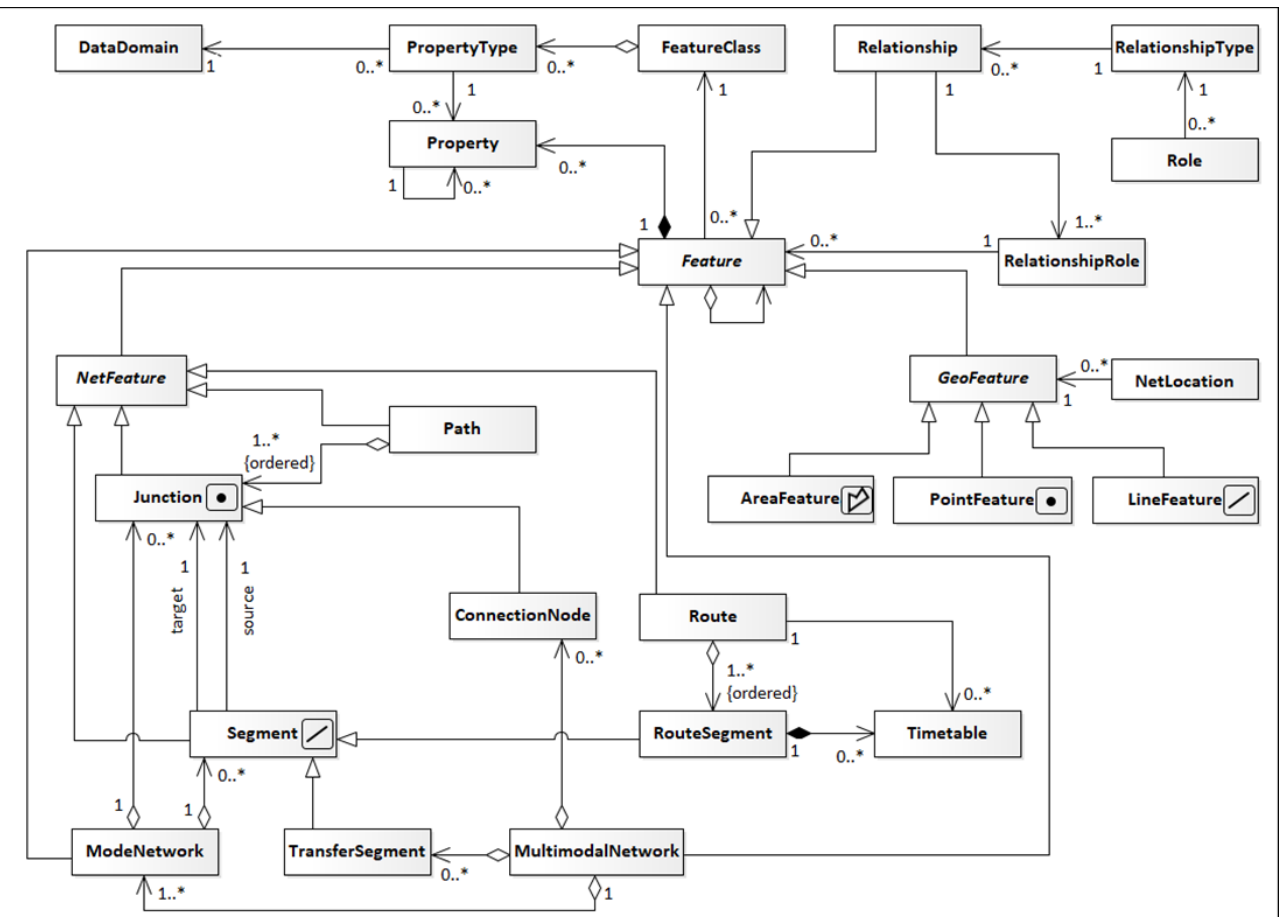
Figure 2. Conceptual schema for the Multimodal Urban Transportation Network in UML notation. Attributes were omitted for